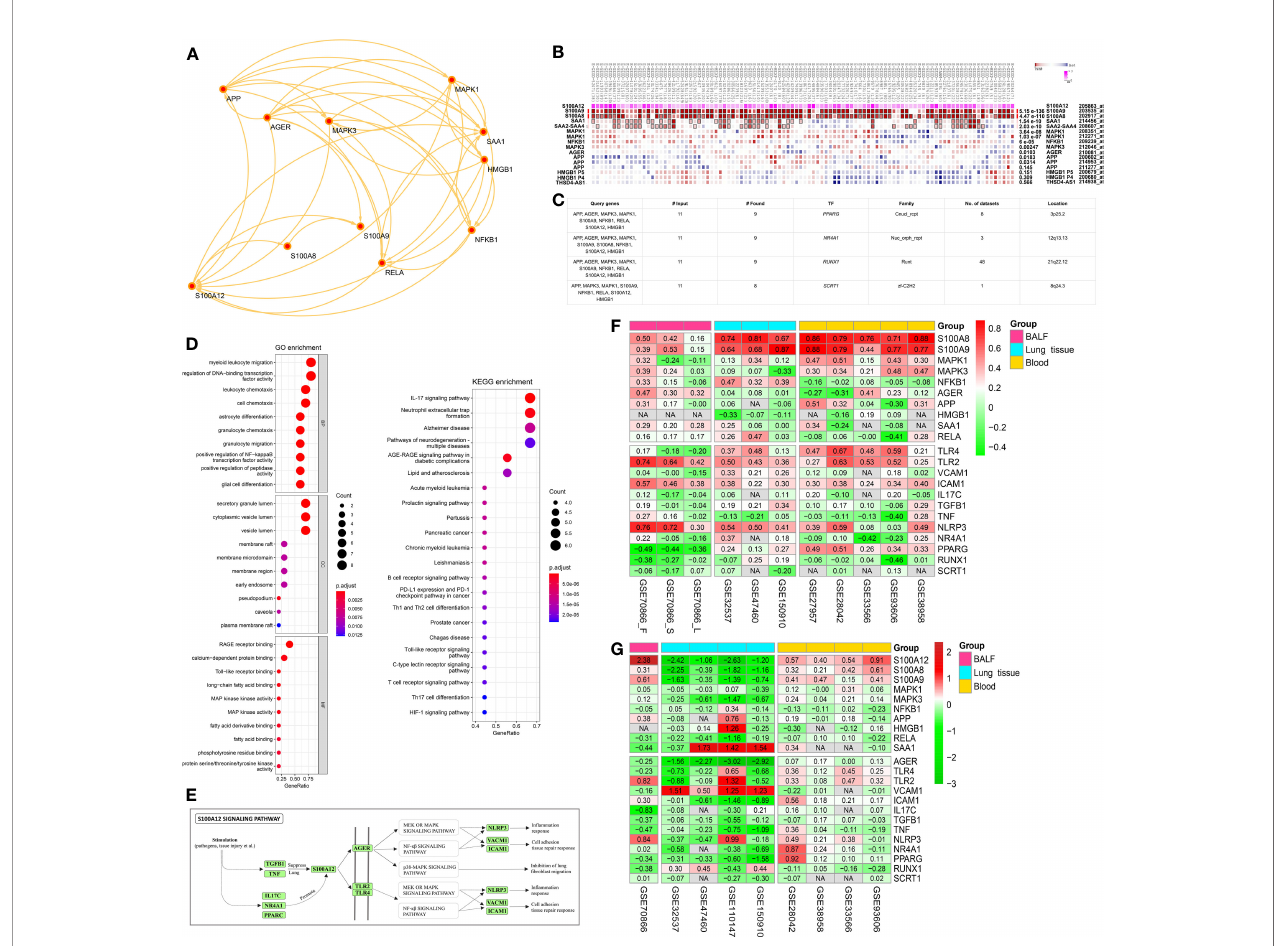
FIGURE 3 | S100A12-related partners and TFs. (A) A protein – protein interaction (PPI) network of S100A12 according to STRING database. (B) The correlation between S100A12 and the 10 genes came from the PPI network according to MEM database. (C) According to the hTFtarget database, the fi rst four TFs of both S100A12 and the 10 interacted genes were found. (D) GO and KEGG pathway analysis of both S100A12 and the 10 interacted genes. (E) Potential S100A12 signaling pathway based on the literatures of PubMed. (F) Co-expression analysis between S100A12 and above genes according to Spearman correlation analysis. Red represents positive correlation, and green represents negative correlation. The numbers represent the correlation coef fi cients, and the darker color represents the better correlation. (G) Heatmap of differential expression analysis between IPF patients and controls according to R package “ Limma ” . Red represents upregulation, and green represents downregulation. The numbers represent the logFC, and the darker color represents the more notable difference. NA, not